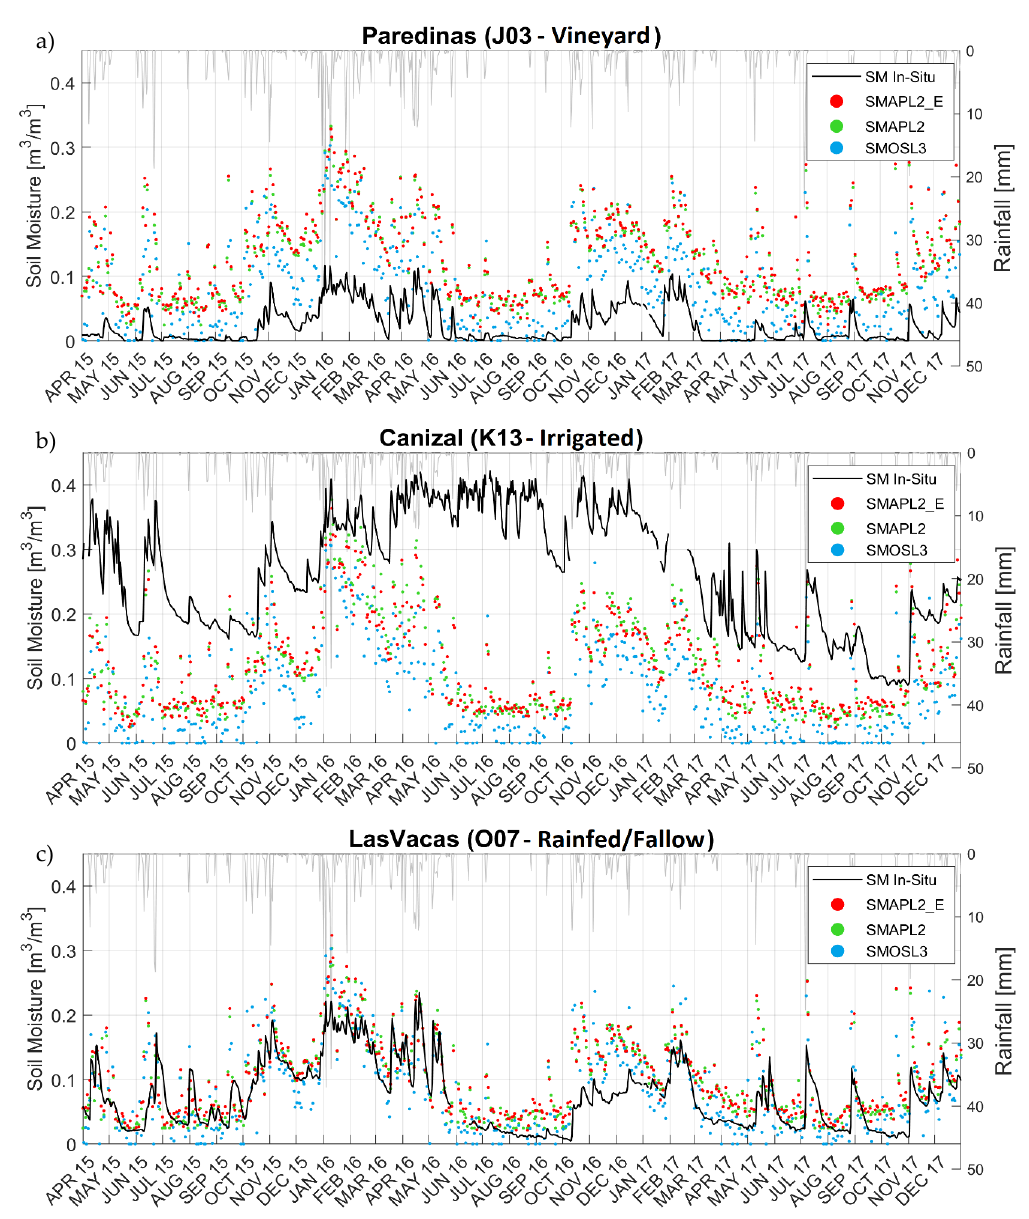
Figure 2. Daily evolution of the in situ SSM (black) and the three low-resolution (radiometer-only) SSM (SMAPL2_E, red; SMAPL2, green; and SMOSL3, blue) at three REMEDHUS stations with different land use: ( a ) J3 (vineyard), ( b ) K13 (irrigated), and ( c ) O7 (rainfed/fallow).